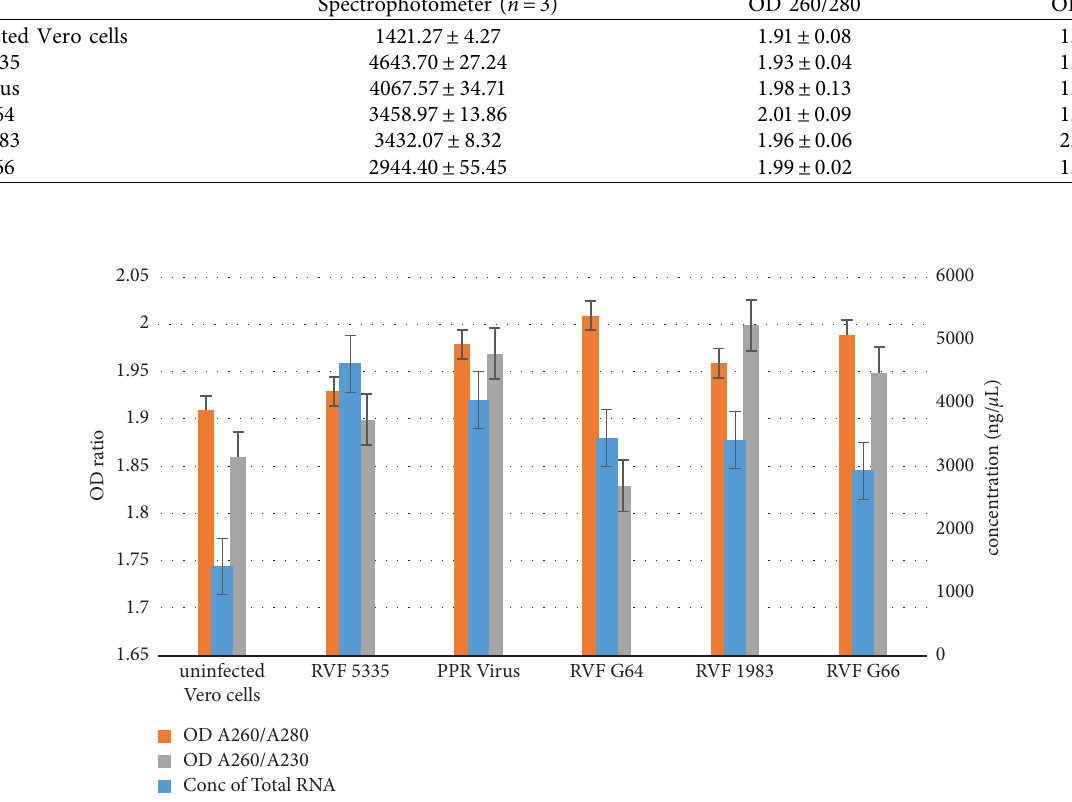
Figure 3: Concentration of total RNA (ng/ µ L), OD ratios of 260/280, and 260/230 of extracted total RNA by Nanodrop 2000c spec- trophotometry. Te bars stand for the standard error ( n �